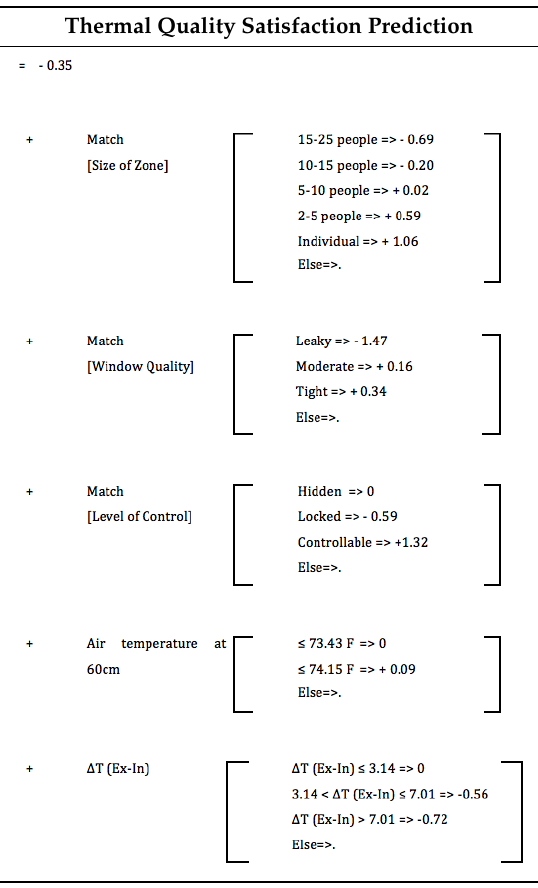
Table 15. Prediction expression of user satisfaction in thermal quality.